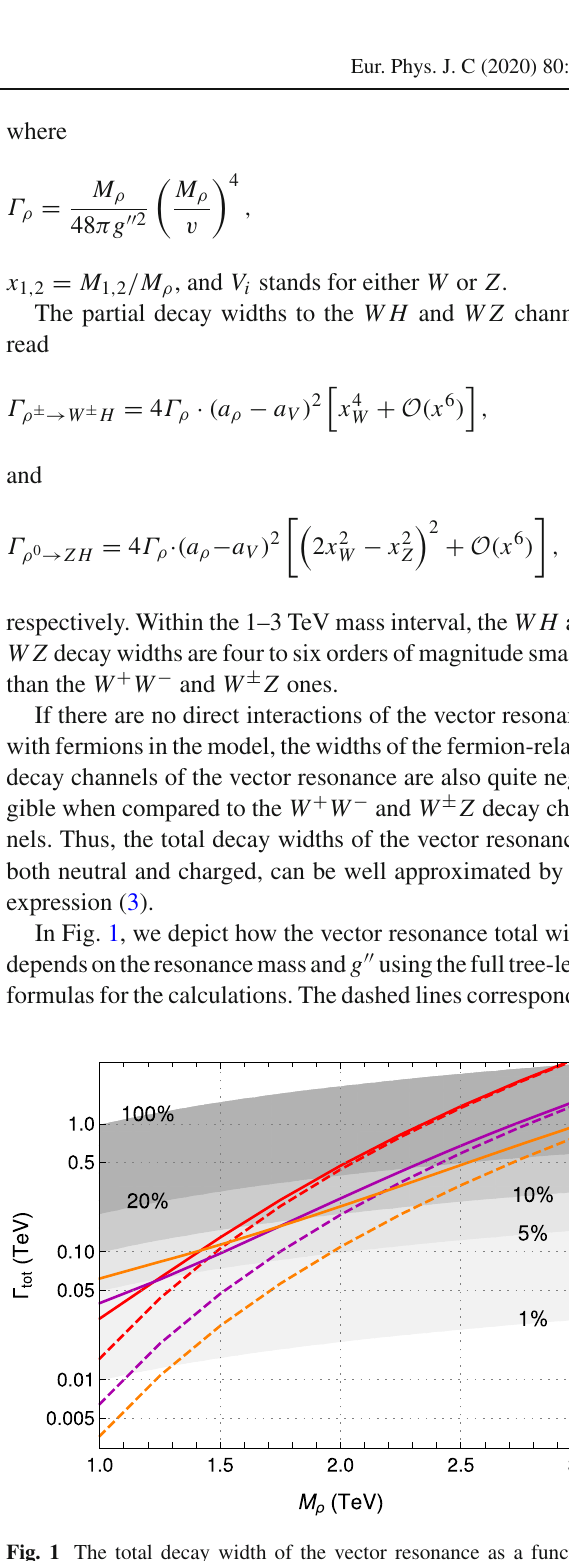
Fig. 1 The total decay width of the vector resonance as a function of the resonance mass. Top to bottom, the dashed lines correspond to g (cid:2)(cid:2) = 12, 18, and 24, respectively, when there is no direct interaction of the vector resonance to fermions. The solid lines representing the case of the direct interactions with b L , R = − 0 . 1, and p = 1 unite with their dashed g (cid:2)(cid:2) -counterparts at the upper right corner of the graph. Different shadings of the background indicate areas with different value ranges of Γ tot / M ρ . The curves do not distinguish between neutral and charged